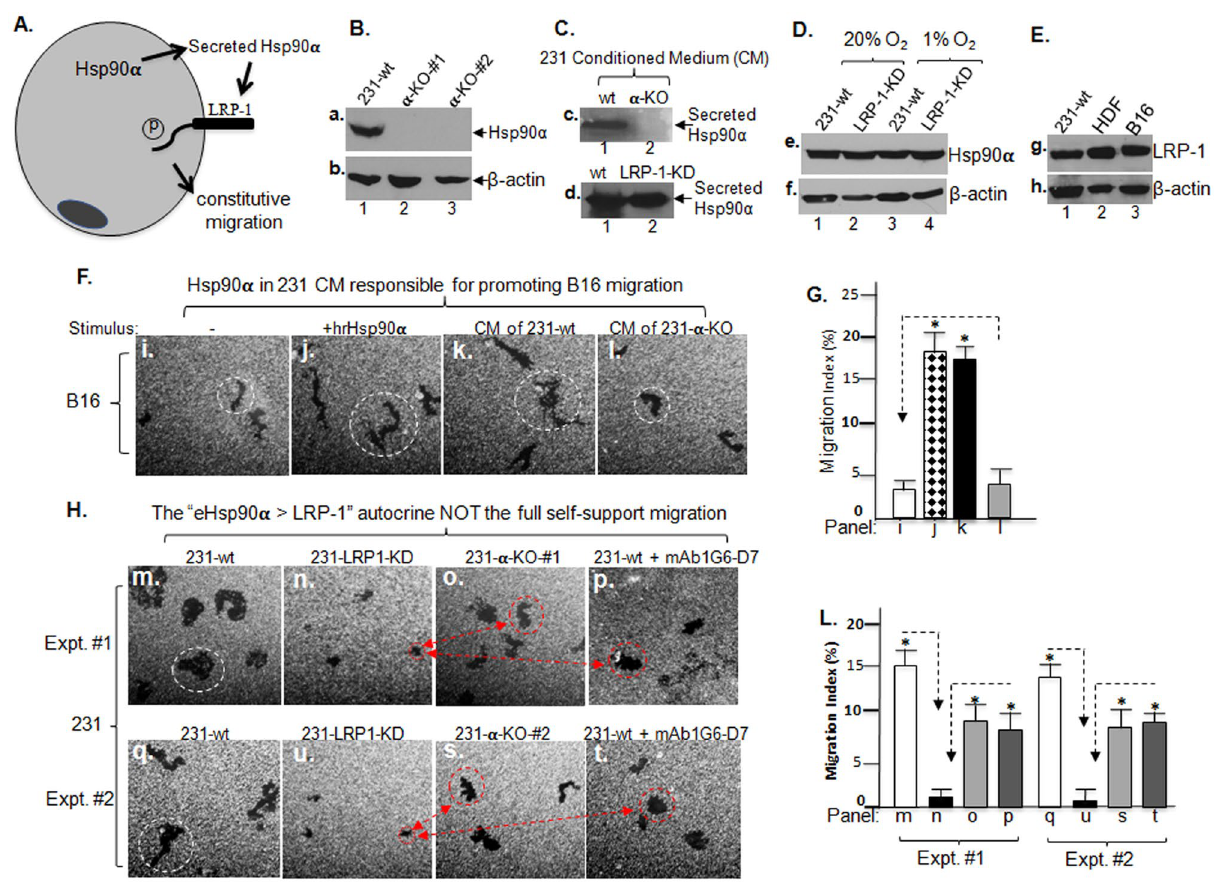
Figure 3. The “eHsp90α > LRP-1 autocrine loop” only accounts for 50% of the constitutive motility of the tumour cells. ( A ) A schematic illustration of the “eHsp90α > LRP-1 autocrine loop” that promotes cell motility. ( B ) Western blot shows 231-wt and two clones of 231-Hsp90α-knockout (231-α-KO) cells (panel a). ( C ) Anti- Hsp90α antibody blotting of secreted Hsp90α in serum-free conditioned medium (CM, 10X) from 231-wt, 231-α-KO (panel c) or 231-LRP-1-KD (panel d) cells. ( D ) Western blot analysis shows the total Hsp90α level in 231-wt or 231-LRP-1-KD cells under normoxia or hypoxia. ( E ) Western blot analysis shows the relative levels of LRP-1 in indicated cell lines. ( F ) CM from 231-wt, but not 231-α-KO, cells stimulated B16 melanoma cell migration (panels k and l vs. panel i), with human recombinant (hr) Hsp90α protein (panel j) as positive control. ( G ) Computer-assisted quantitation of the B16 cell migration shown in panel F as Migration Index (%) (“Methods”). CM from 231-α-KO cells completely lost pro-motility activity (panel l). Asterisks indicate significance of the induced migration by indicated stimuli (panels j, k) versus the serum-free control (panel i). ( H ) The indicated cells were simultaneously compared for their motility under serum-fee conditions. Neither total α-KO (panels o and s) nor extracellular blockade of secreted Hsp90α function by mAb1G7-D7 (panels p, t) re-produced the degree of inhibition of cell motility by LRP-1-KD (panels n and u), in reference to 231-wt cells (panels m and q). ( L ) Computer-assisted quantitation of the cell migration data with indicated panels. Asterisks indicate the significance of indicated cell motility over that of the LRP-1-KD cells. All experiments were repeated multiple times to reach the final